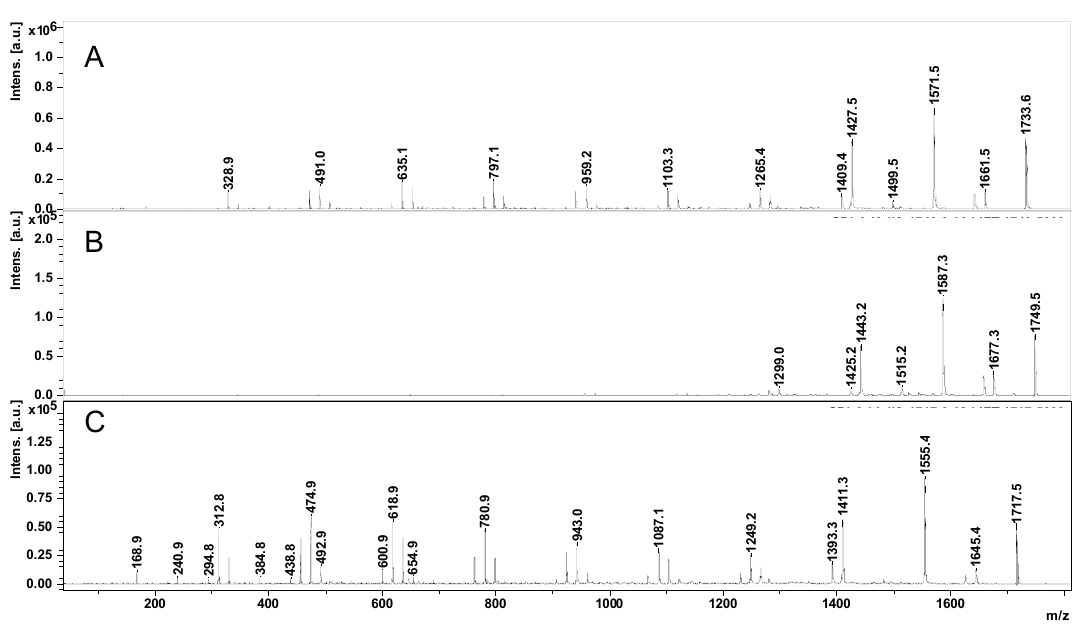
Figure 4. MALDI LID MS/MS of CD-LA 4 precursor ions: Na ( A ), K ( B ), and Li ( C ) charged. By analyzing the MS/MS spectra from Figure 4, it may be observed that the fragments resulting from the cleavage of the semiacetalic bonds ( G series) were clearly appearing in the fragmentation profiles of Na + - and Li + -charged species, while the K + -charged parent ions yielded mostly fragments issued from the cleavage of the ester bonds ( E series). The observed selectivity may be useful in analyzing the moieties connected via ester bonds to the CD. The propensity for ester fragmentations has been confirmed also for CD-LA with 18 lactate units [CD-LA 9 + K] + and CD-LA with 24 lactate units [CD-LA 12 + K] + , as shown in Figure 5.